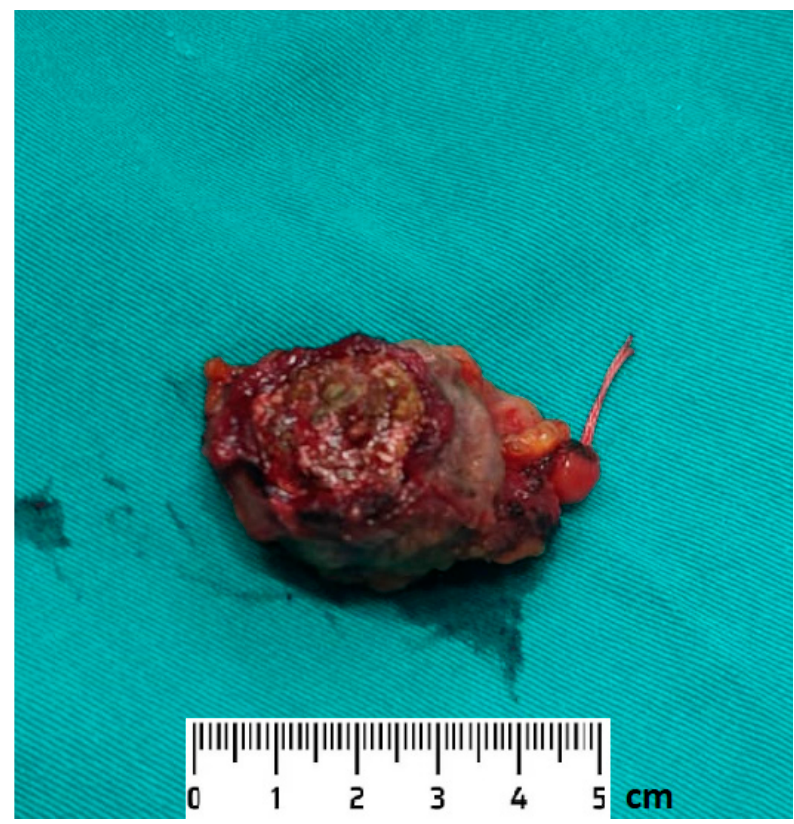
Figure 4. Excised bladder tumour